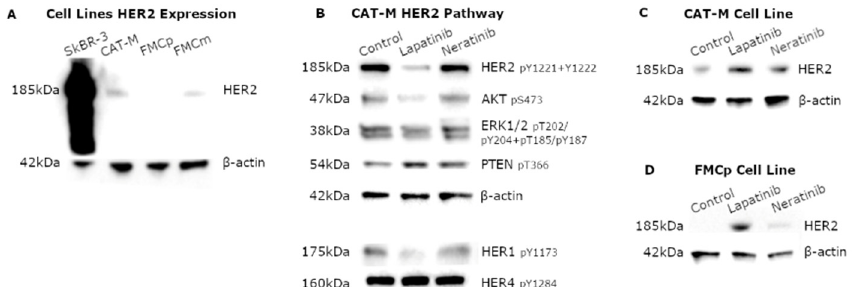
Figure 2. Feline cell lines presented low HER2 expression, showing altered phosphorylation levels of HER2 and its downstream effectors after TKi exposure. ( A ) CAT-M and FMCm cell lines presented low HER2 expression levels, with no expression detected in the FMCp cell line. ( B ) After exposure to lapatinib, the CAT-M cell line showed decreased phosphorylation levels of the HER1 (pY1173), HER2 (pY1221 + Y1222) and of its downstream effectors, AKT1 (pS473) and ERK1/2 (pT202/pY204 + pT185/pY187), coupled in an increased of PTEN phosphorylation at Thr366. Results were less perceptible when cells were exposed to neratinib. ( C ) TKi exposure, particularly, lapatinib, increased HER2 levels not only in CAT-M cells, but also in ( D ) FMCp cells. β -actin was used as loading control.